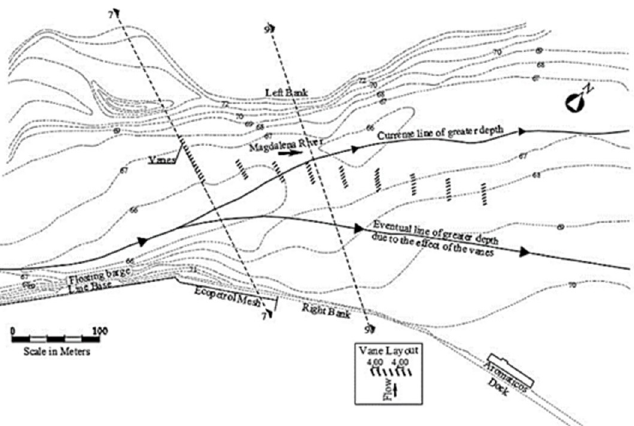
Figure 3. Location of the submerged vane field in front of ECOPETROL's Aromatics pier (Hidroconsulta, 1991).